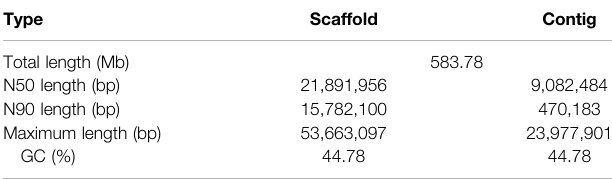
TABLE 1 | Genome assembly statistics for the Lota lota